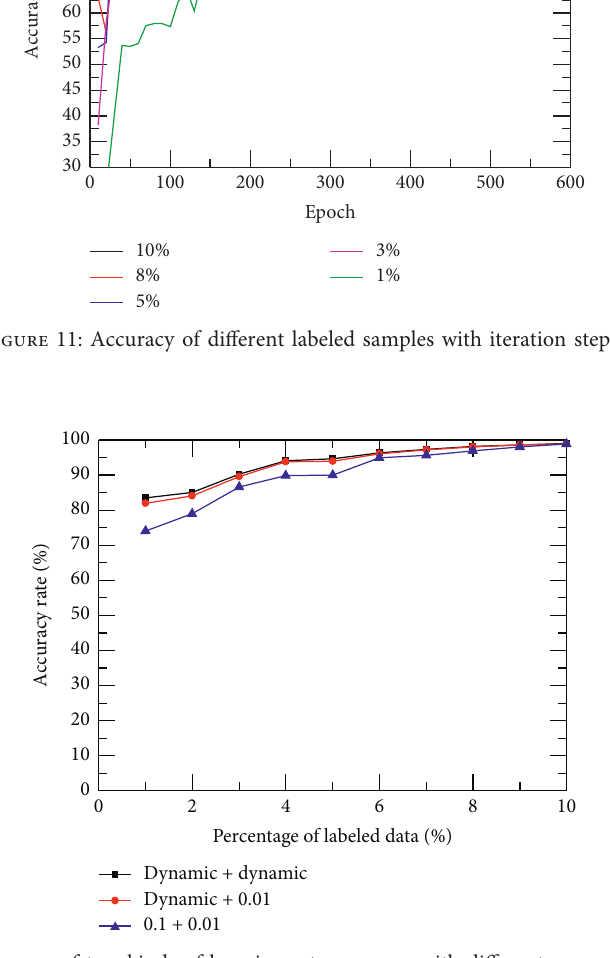
Figure 12: The accuracy curve of two kinds of learning rate accuracy with different percentages of labeled samples.